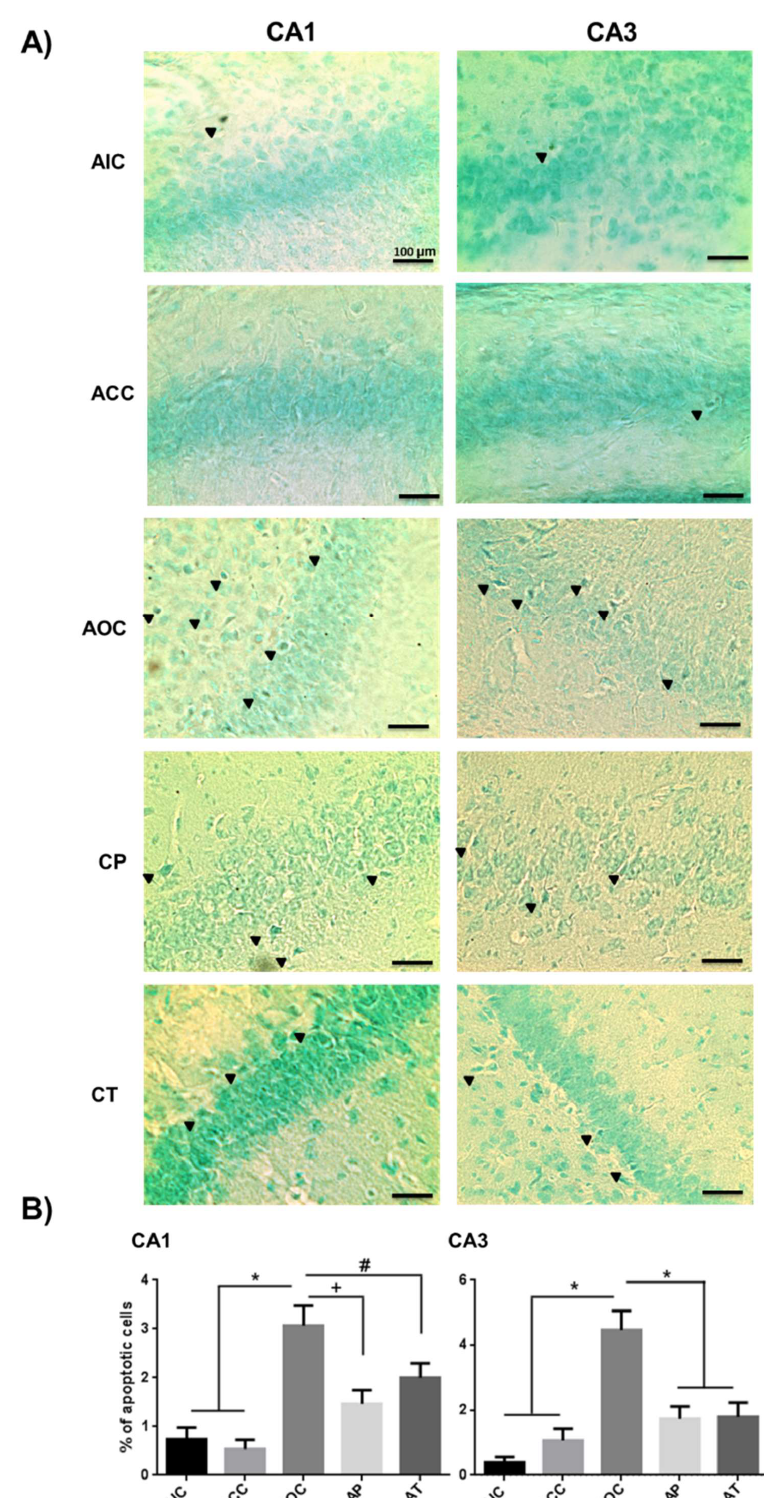
Figure 6. E ff ect of CUR on the quantitation of apoptotic hippocampal cells in the acute phase. ( A ) Representative images of apoptotic cells (black arrows) in the CA1 and CA3 regions of the rat hippocampus in the acute phase are shown. The AOC group developed a higher percentage of apoptotic cells than those found in the AP and AT groups. Scale bars 100 µ m. ( B ) Total percentage of apoptotic cells are shown in the graph as mean ± SEM. * p < 0.001, + p < 0.01, # p <